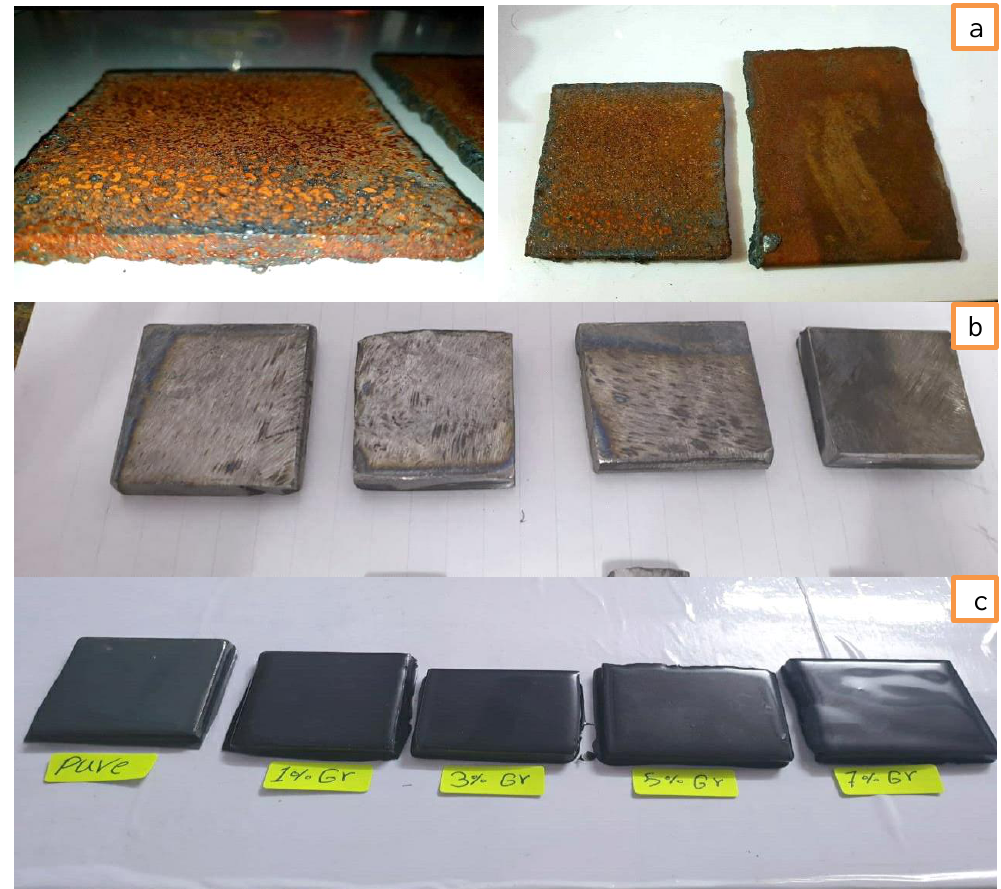
Figure 3: The samples: a- before cutting and cleaning, b- after cutting and cleaning, and c- after coating with blend and nano